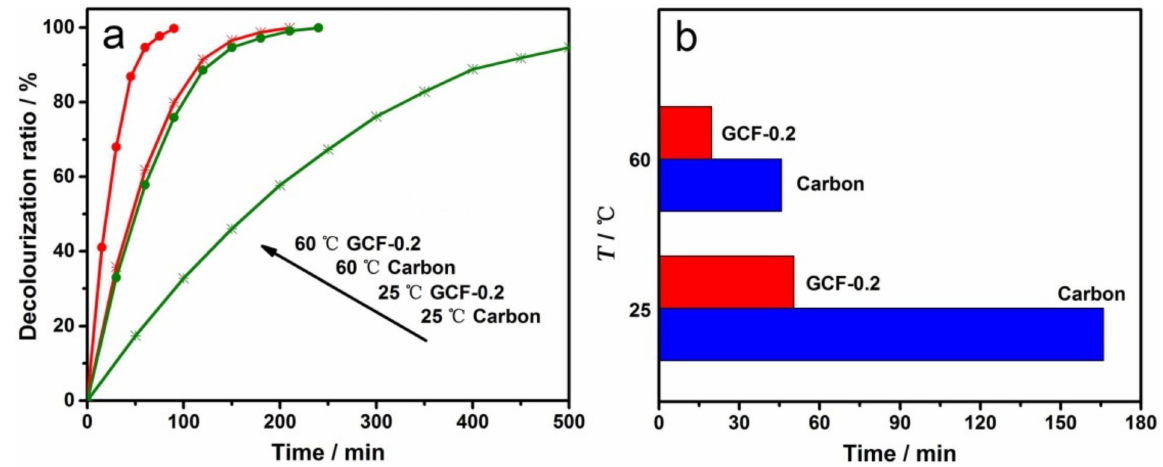
Figure 8. Decolorization ratio-time curves ( a ) and temperature-time histogram when the decolorization ratio is 50% ( b ) with different cathodes at different temperatures.